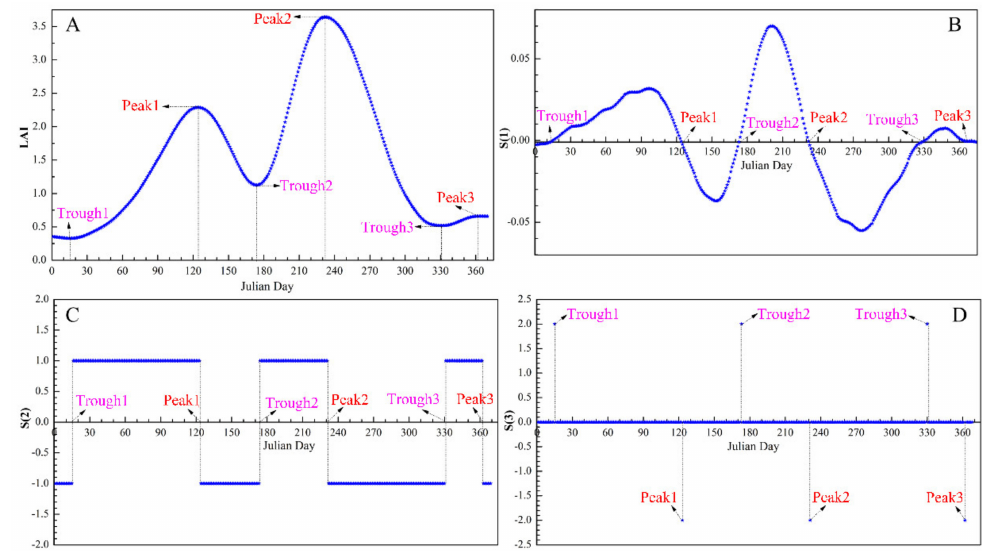
Figure 4. Original LAI time series together with results of processing during the different steps of the second-order difference algorithm. ( A ) Original smoothed LAI curve; ( B ) result of sequence S(1); ( C ) result of sequence S(2); ( D ) result of sequence